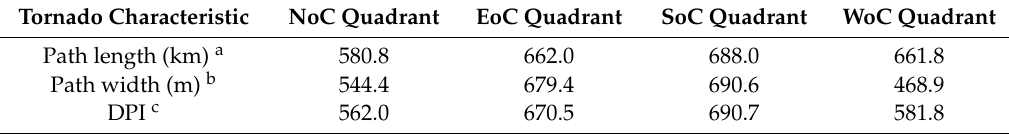
Table 8. Mean ranks used in the Kruskal-Wallis tests for the north-of-center (NoC), east-of-center (EoC), south-of-center (SoC), and west-of-center (WoC) quadrants. Results of the Kruskal-Wallis tests are located below the table. Post-hoc pairwise comparisons indicate that, for all three variables, the mean ranks of the EoC and SoC quadrants are significantly greater than the mean rank of the NoC quadrant.